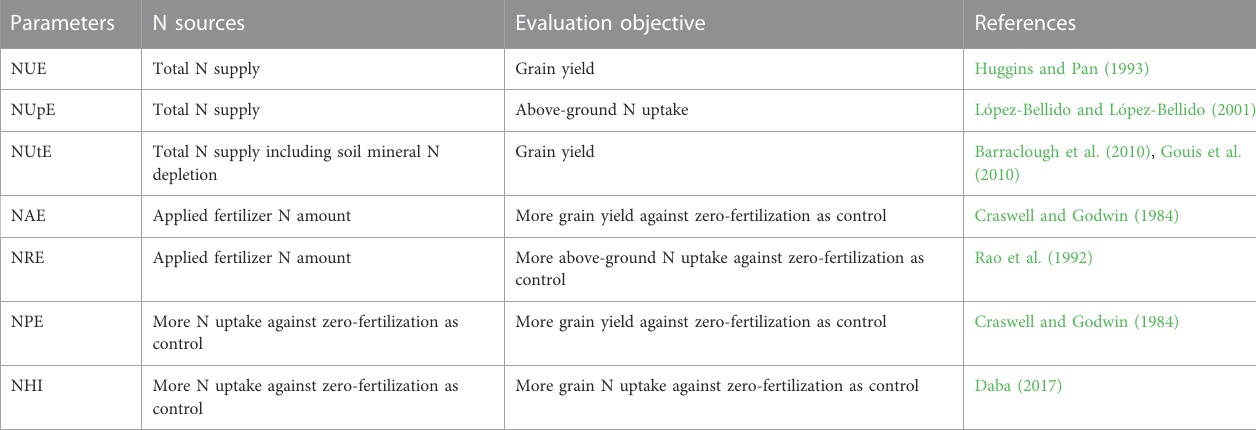
TABLE 4 The summary of parameters for N use ef fi ciency evaluation. Parameters